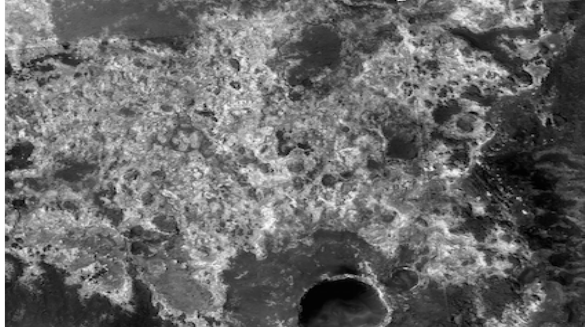
Figure 3. Mosaic of 4 co-registered CTX images that overlap with MC11-E quadrangle. The images are the following: T01_008847_2056,P22_009682_2048, B09_13229_2047 and